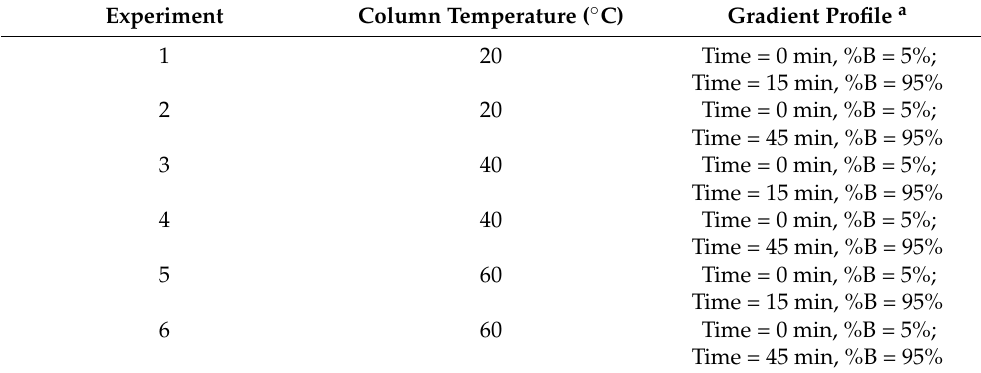
Table 4. Screening sequence used to optimize the column temperature and gradient elution. See Materials and Methods for other conditions.